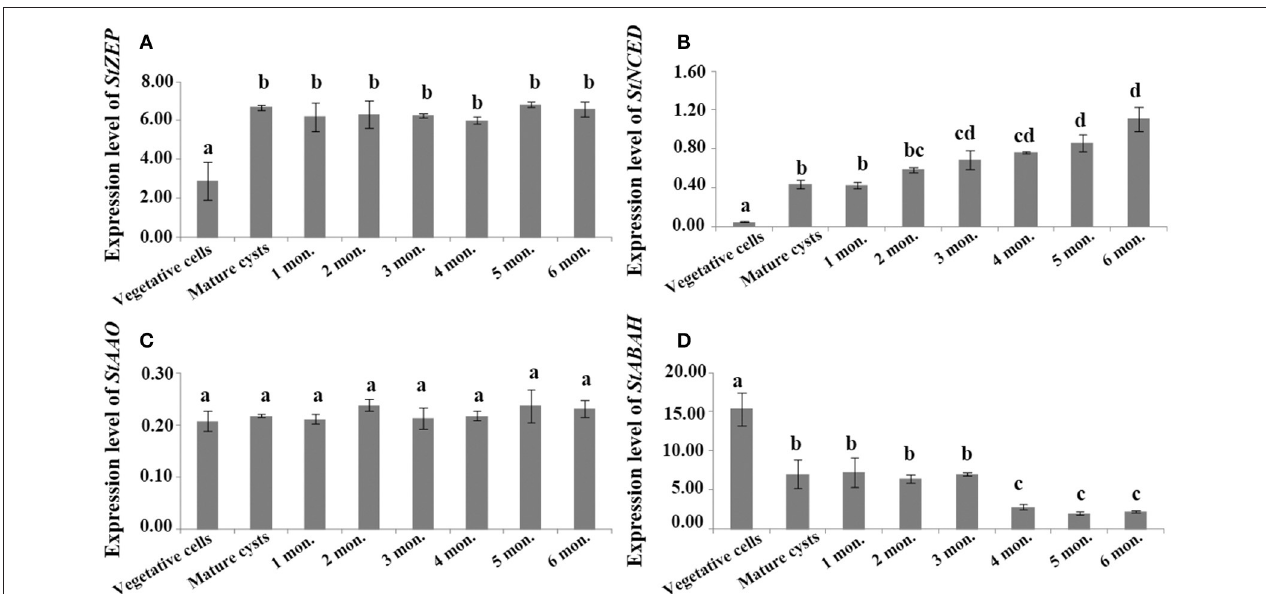
FIGURE 4 | The transcript levels of genes associated with ABA biosynthesis and catabolism, (A) StZEP (B) StNCED (C) StAAO (D) StABAH , relative to MDH (reference gene) in resting cysts stored at 4 ± 1 ◦ C in darkness for different periods of time (0–6 month). The Y axis shows the expression levels of targeted genes relative to the reference gene; Significant differences are presented with different letters above bars at p < 0.05; same letter denotes no significant difference. Values are presented as mean ± standard deviation, Error Bars = SD, n = 3.